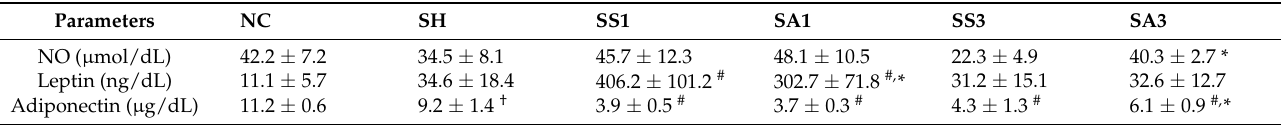
Table 3. Plasma nitric oxide (NO) and adipokines among the experimental groups.